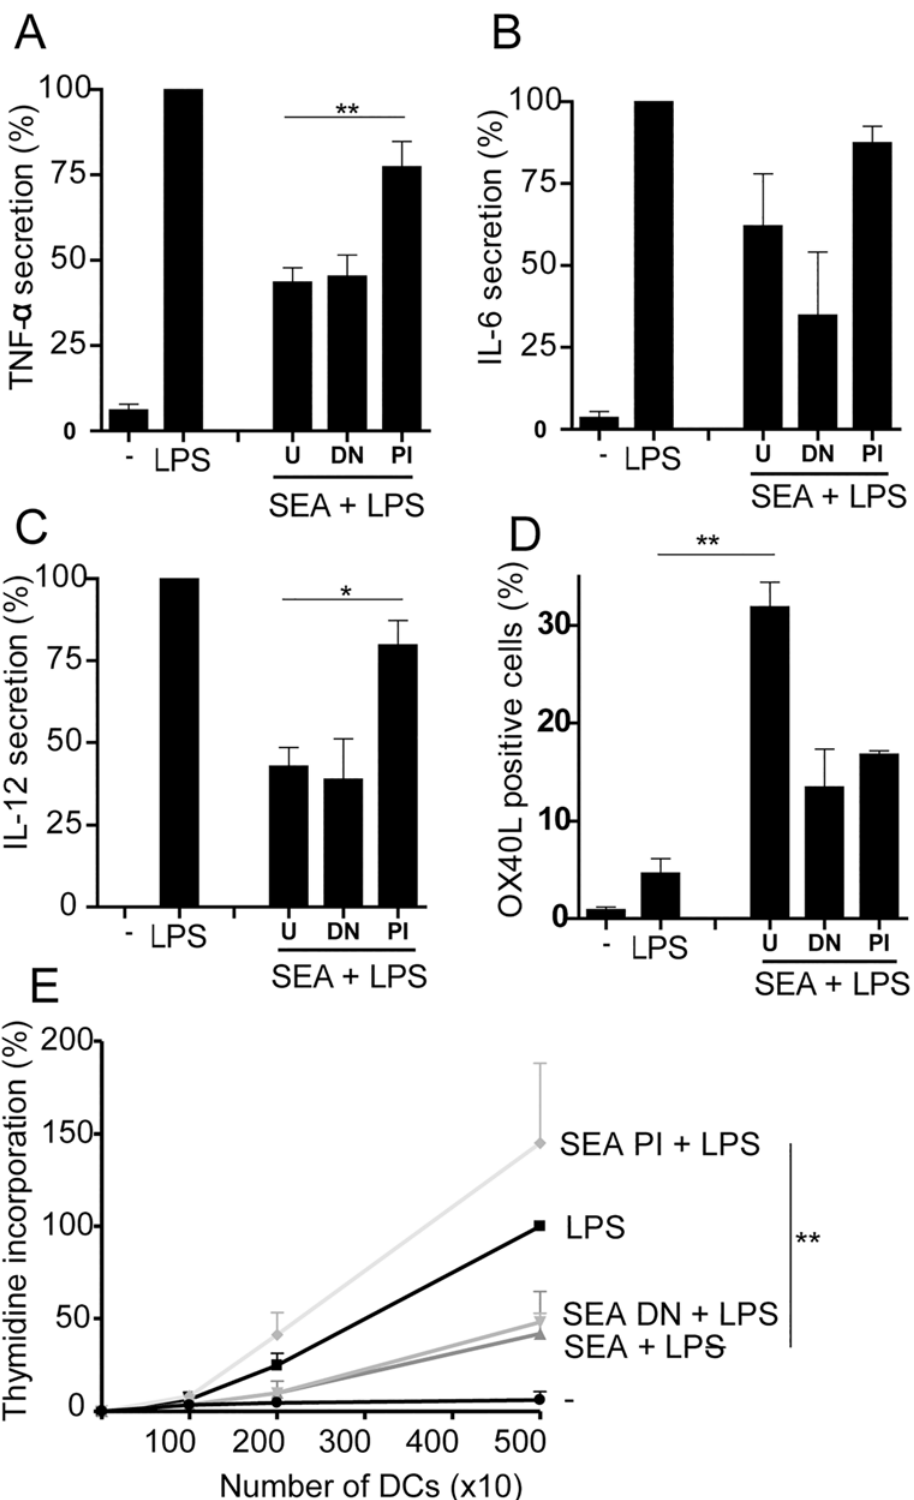
Fig 2. The ability of S . mansoni SEA to suppress LPS-induced human dendritic cell (DC) activation and OX40L expression on DCs is reduced after periodate treatment of SEA. DCs were incubated with LPS, with or without either untreated (U), heat treated (DN) or periodate (PI) treated SEA (40 μ g/ml) for 24h. In A , B , and C , respectively is shown the secretion of TNF α , IL-6 and IL-12, which were determined in the supernatant by Luminex multiplex bead